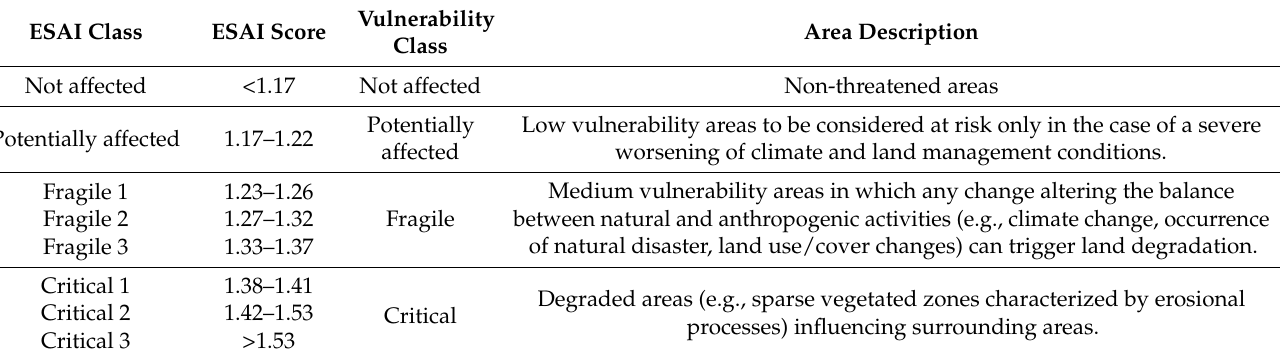
Table 1. Characterization of the eight classes segmenting the ESAI.